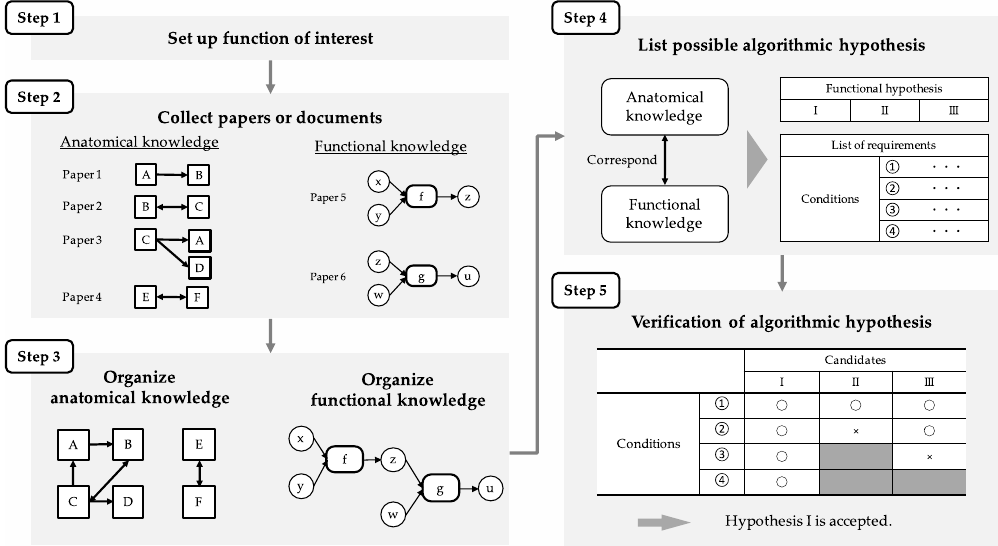
Figure 4. Generalized procedure for finding function-specified region (FSR). Steps 1 to 3 correspond to the review process. In Step 4, the algorithm was constructed, and conditions required for its execution are listed. In Step 5, the algorithm is compared with the SDNC to verify whether region structure, connections, and cell-firing pattern indispensable for execution corresponded to required